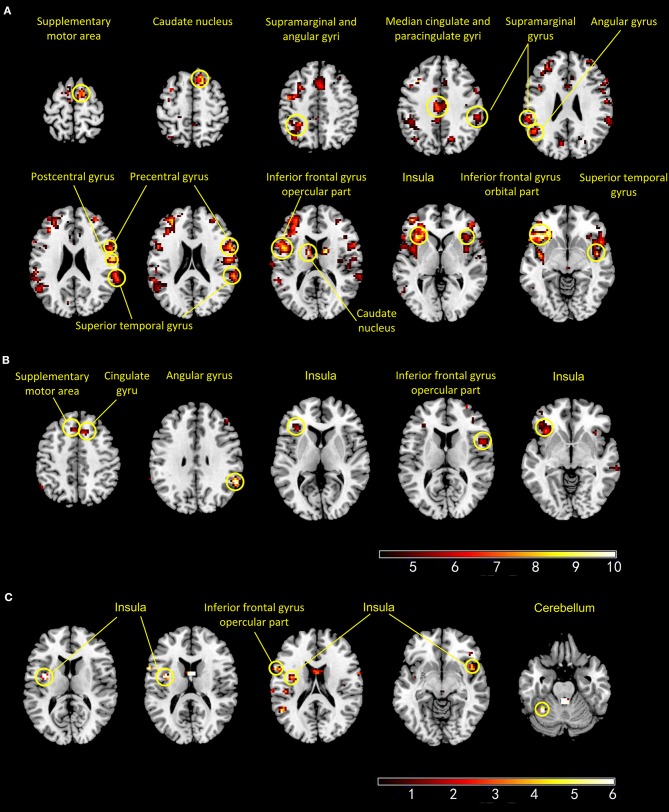
Panels (A,B) show the active regions during pain session in the healthy controls (A) and patients with bipolar disorder (B). Panel (C) shows areas that exhibited significant increase in BOLD signal intensity (HCs > BPs) (p < 0 001, uncorrected).